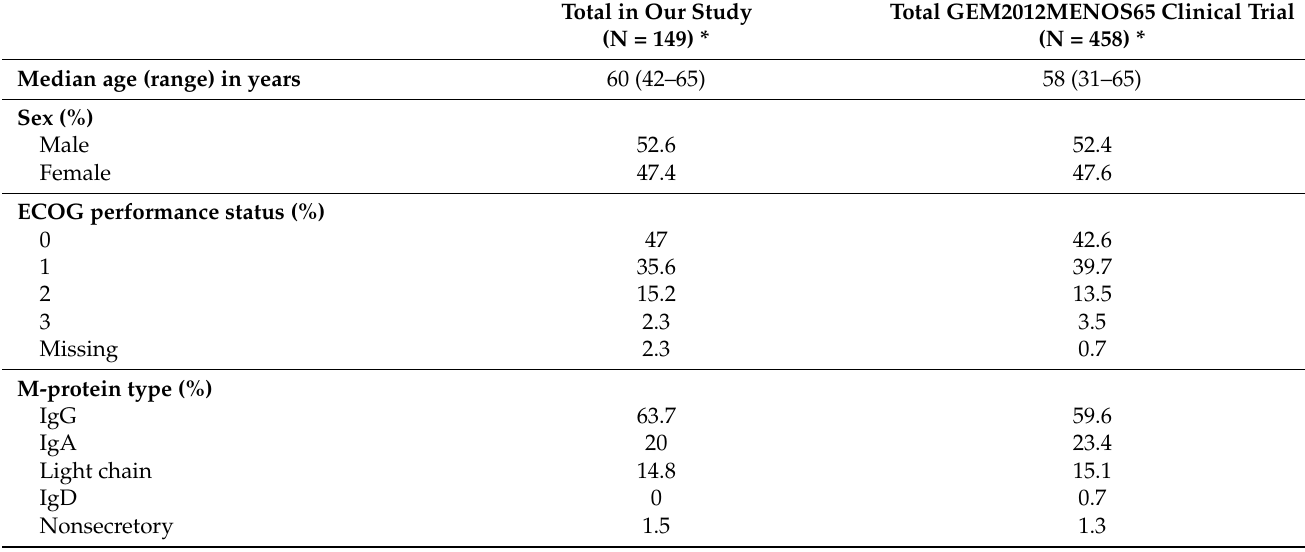
Table 1. Main clinical patient characteristics. ECOG, Eastern Cooperative Oncology Group; ISS, International Staging